Question: What type of chart is this?
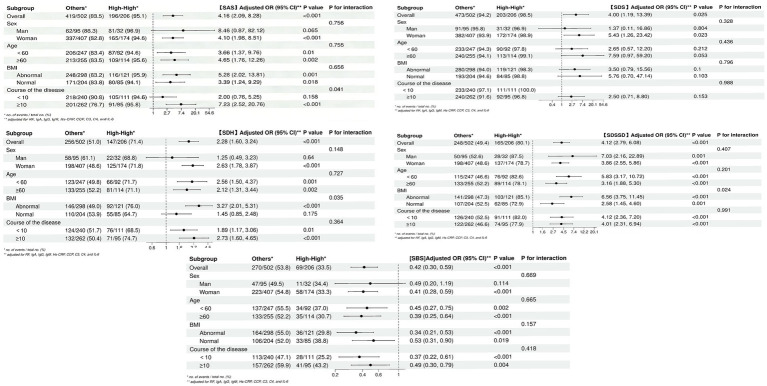
Answer: forest